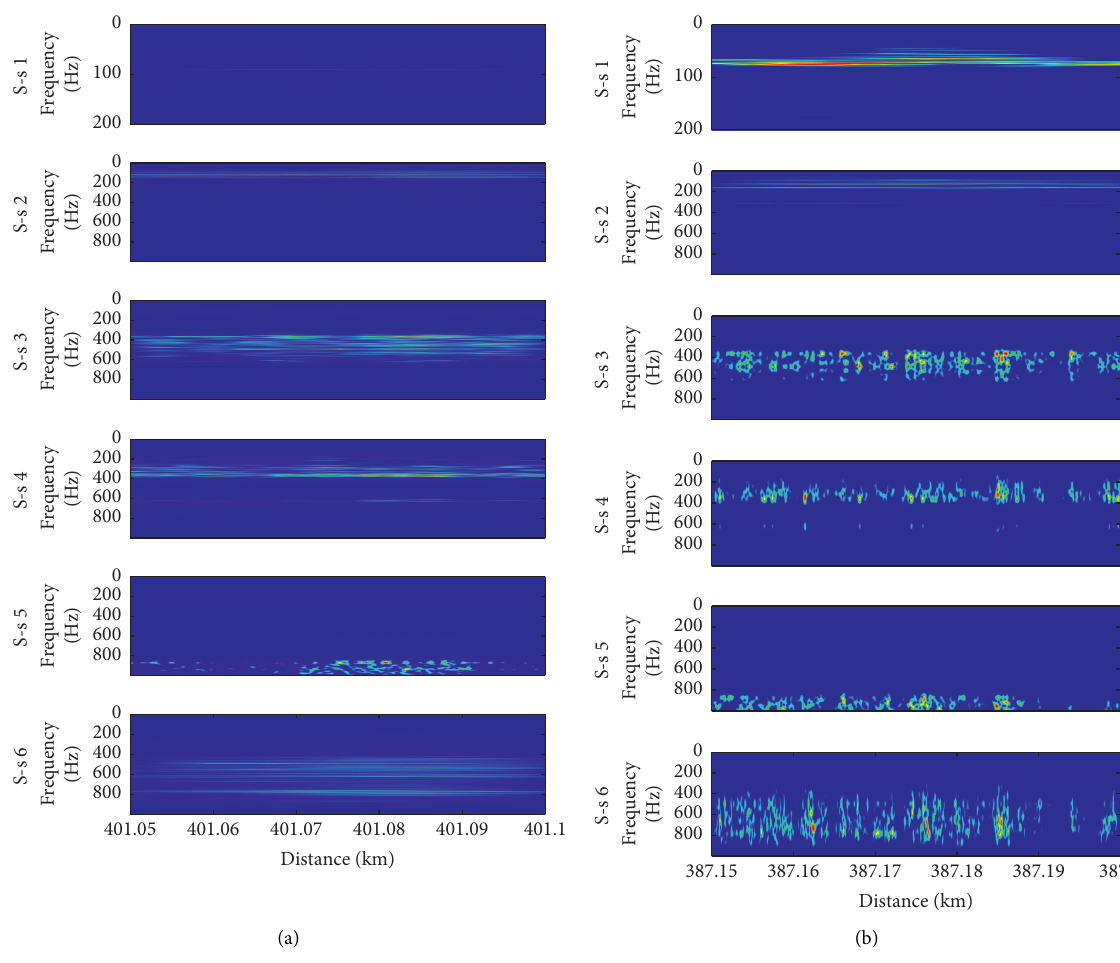
Figure 8: The plots of the time-frequency distribution for the six subsignals for (a) the normal rail sections and (b) the corrugation rail section. Table 1: The Renyi entropy values for a normal section and a corrugation section.